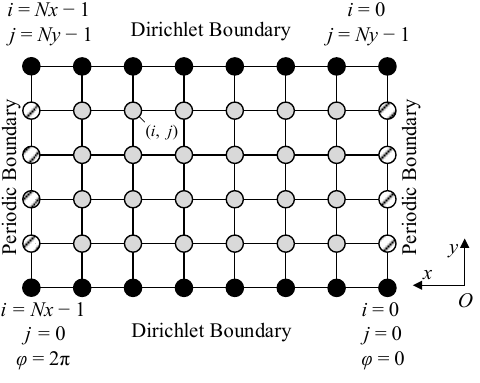
Figure 3. Structural grids.